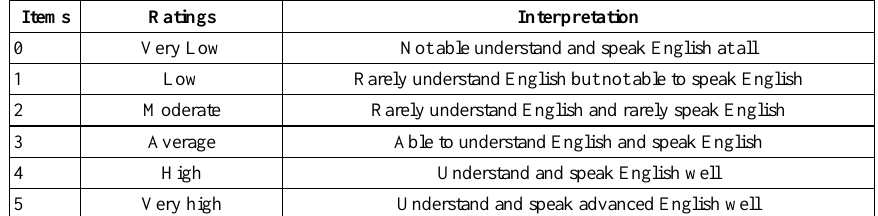
Table 2. Interpretation of 5-Likert rating